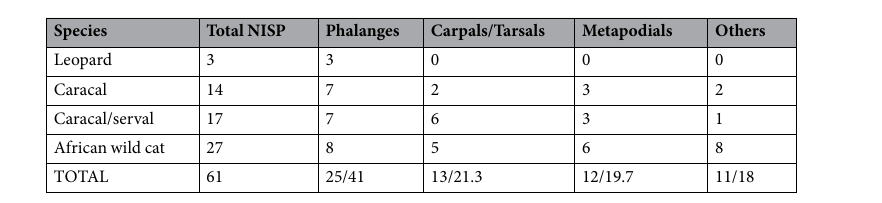
Table 2. Anatomical distribution of the felid skeletal elements (data in NISP and